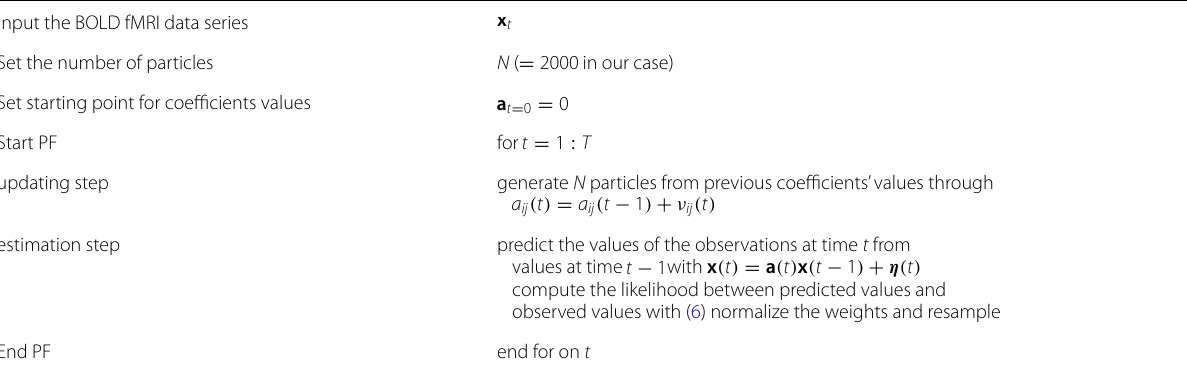
Table 1 Schematic description of the PF algorithm Input the BOLD fMRI data series x t Set the number of particles N ( = 2000 in our case) Set starting point for coefficients values a t = 0 = 0 Start PF for t = 1 : T updating